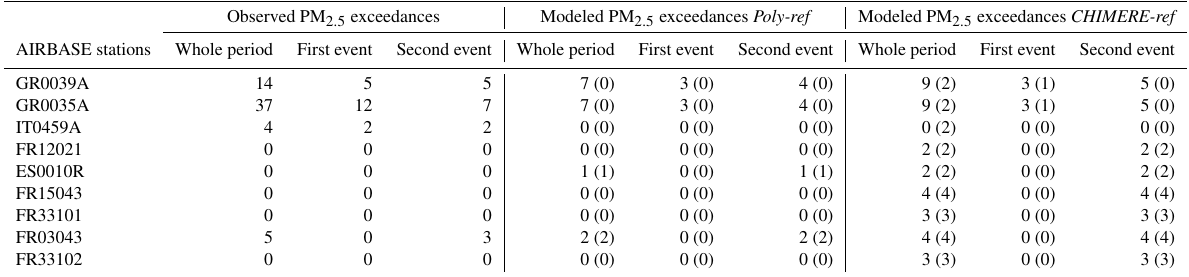
Table F1. Modeled and observed PM 2 . 5 exceedances at each AIRBASE station. Values between brackets correspond to modeled PM 2 . 5 exceedances for simulations without fire emissions ( Poly-Nofires and CHIMERE-Nofires ).